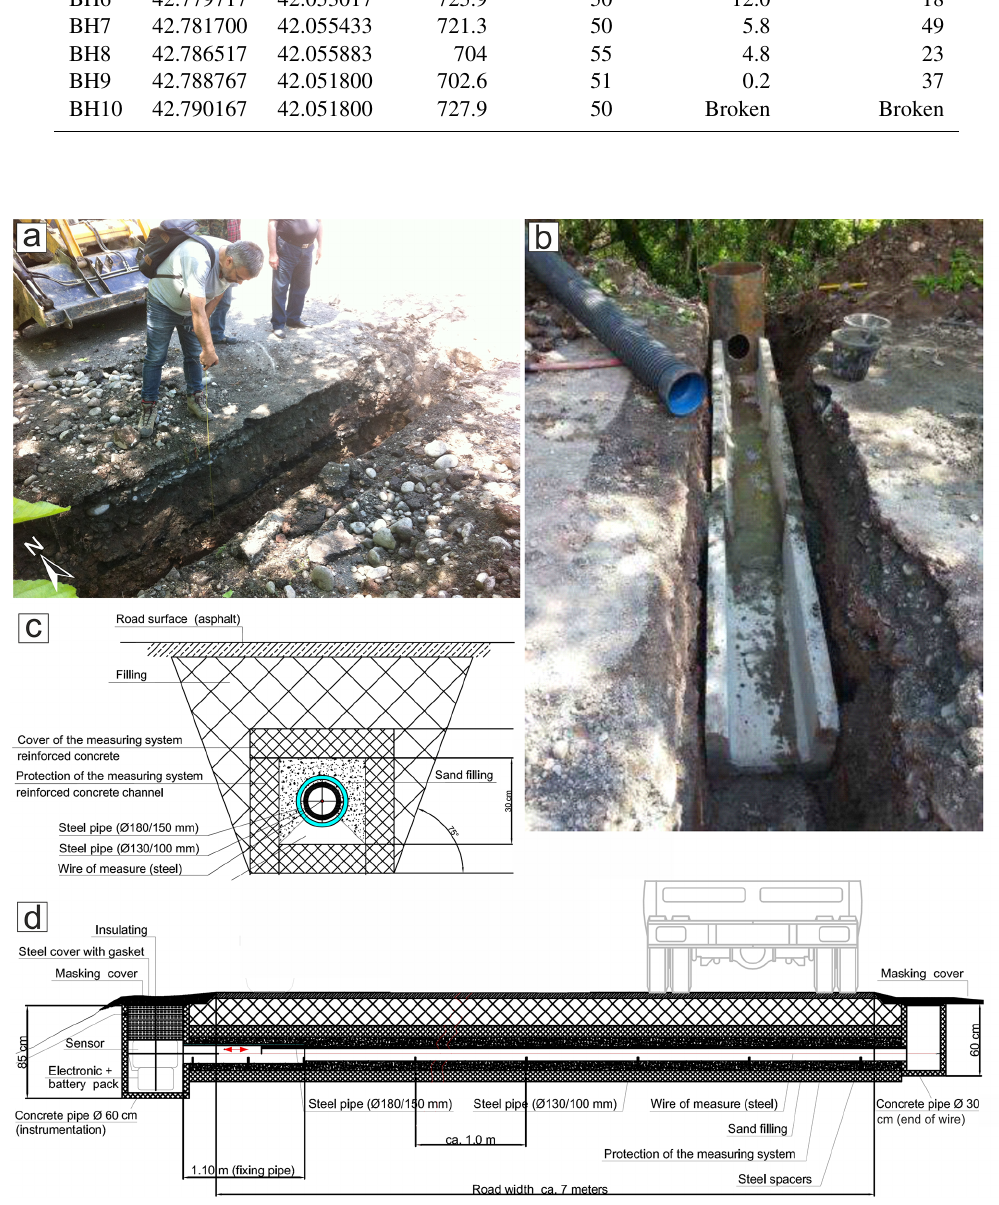
Figure 5. (a) Opening of trench no. 1. (b) Installation of the concrete protection for the extensometer. (c) Section transversal to the exten- someter system. (d) Longitudinal section of the extensometer system. Location of the two measurement stations provided in Fig.